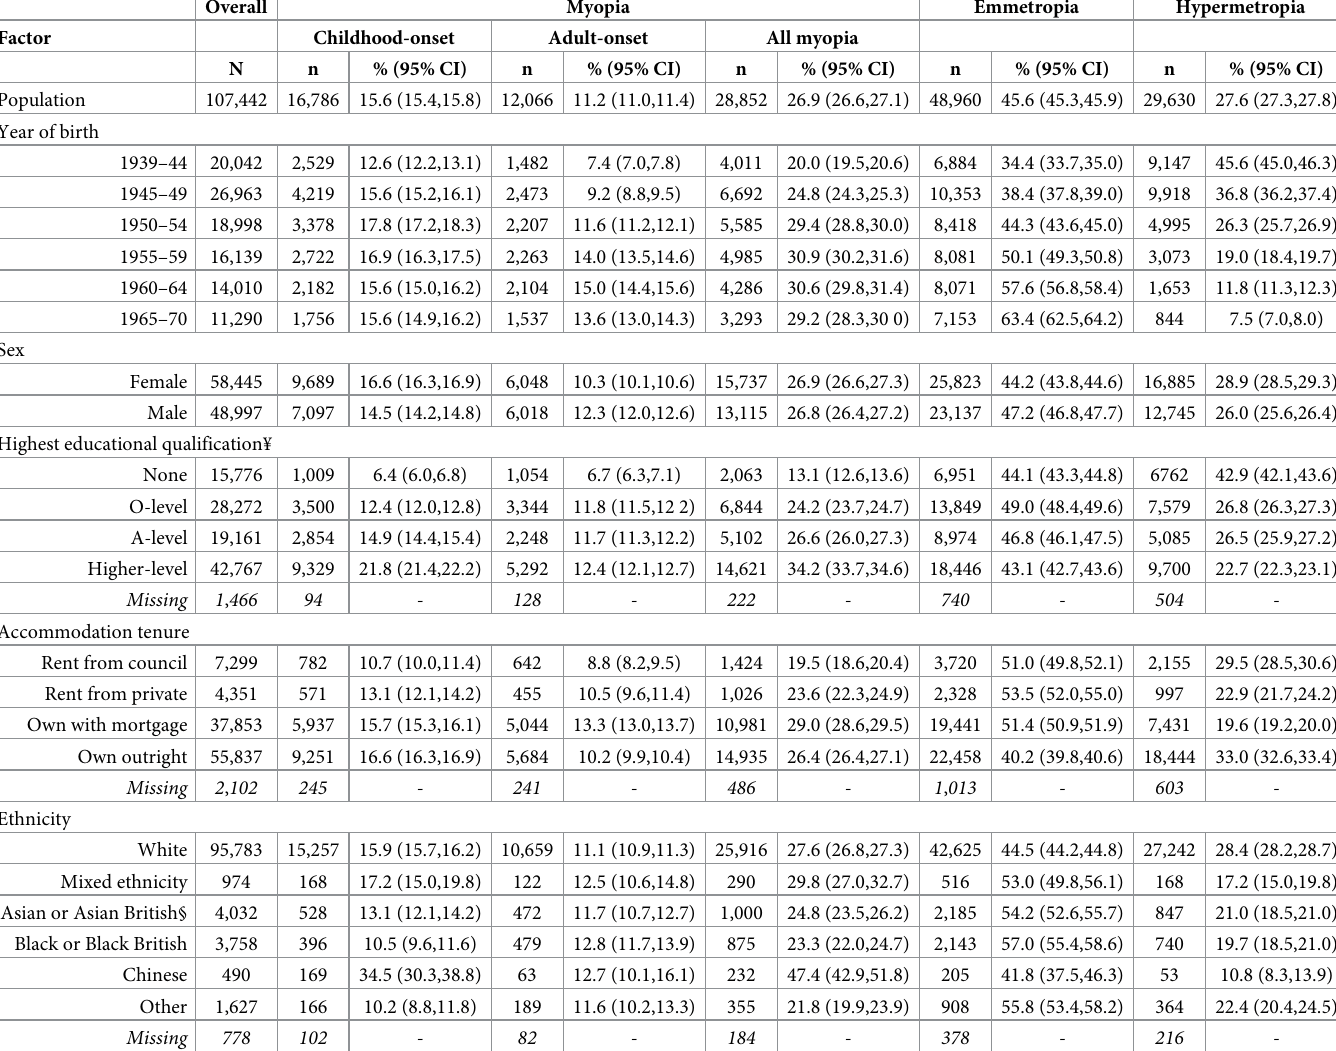
Table 1. Frequency of myopia (all, childhood-onset and adult-onset) and emmetropia in the UK Biobank population: Distribution of socio-demographic and envi- ronmental